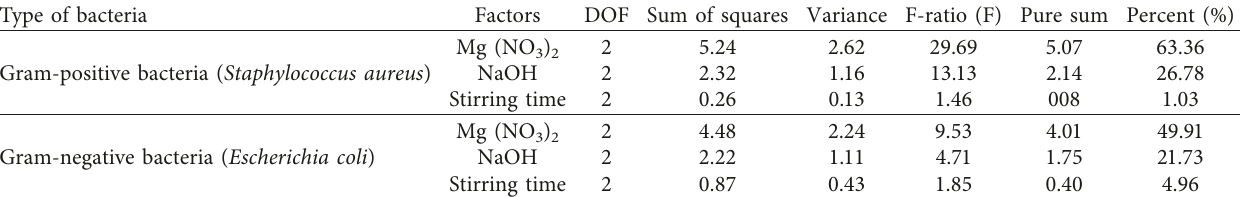
Table 4: The ANOVA test for studied factors on reducing the growth of bacteria.